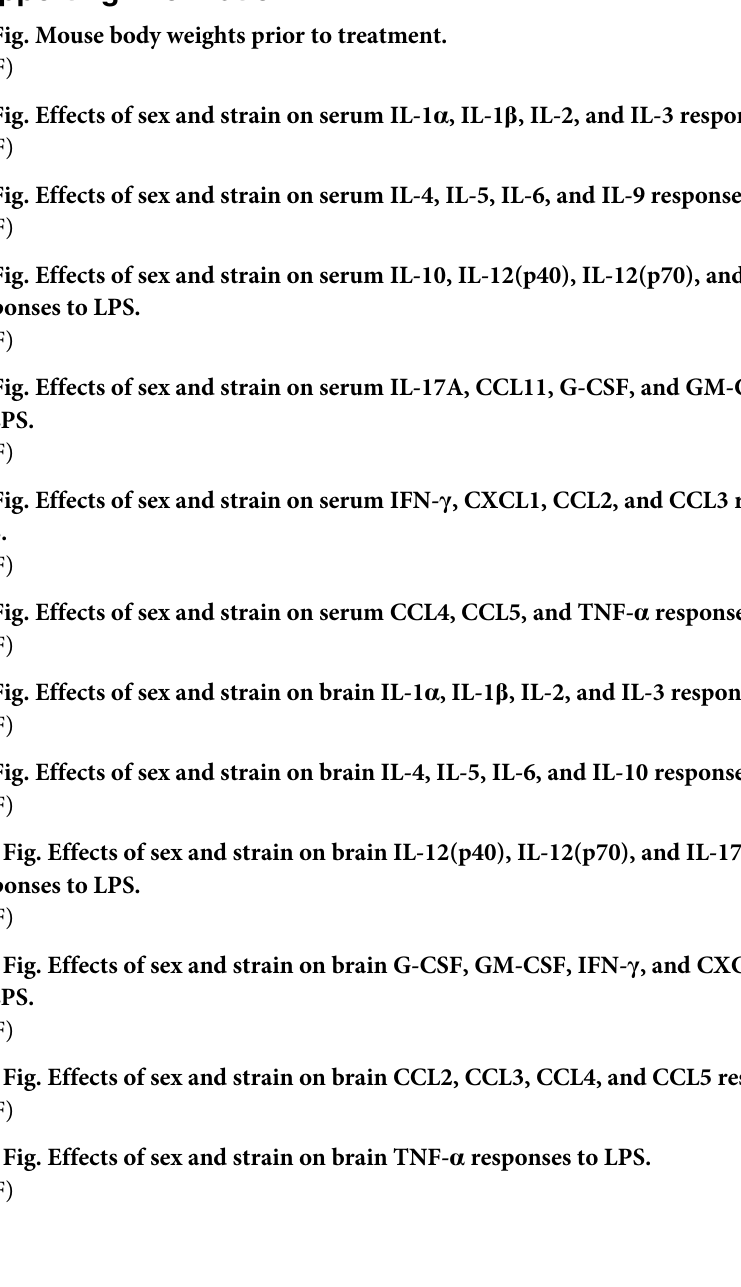
Fig 7. Correlations of serum cytokines with brain/serum ratios of 99m Tc-DTPA. Data from the 3 injection LPS groups for all sexes and strains were pooled and correlated for each detectable cytokine in brain. Graphs are showing statistically significant Spearman correlations. Blue dots = male CD-1, black dots = male C57, red dots = female CD-1, yellow dots = female